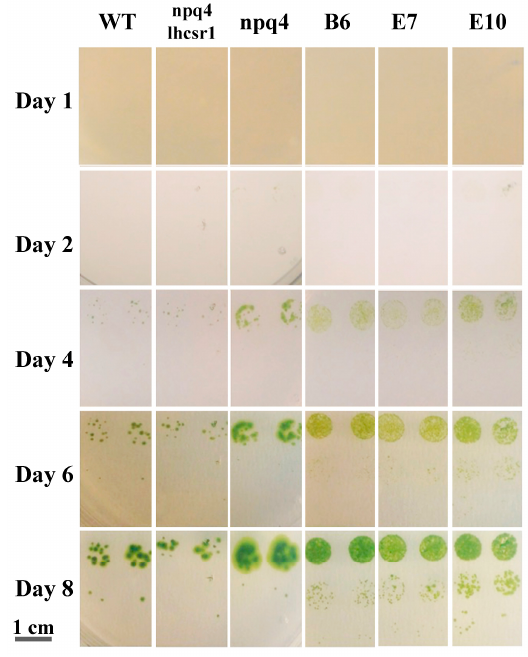
Figure 7. Spot test for WT and transformed lines. Each genotype was spotted on solid minimum medium with three different cell amount (10 2 ,10 3 and 10 4 cells). Scale bar is reported on bottom